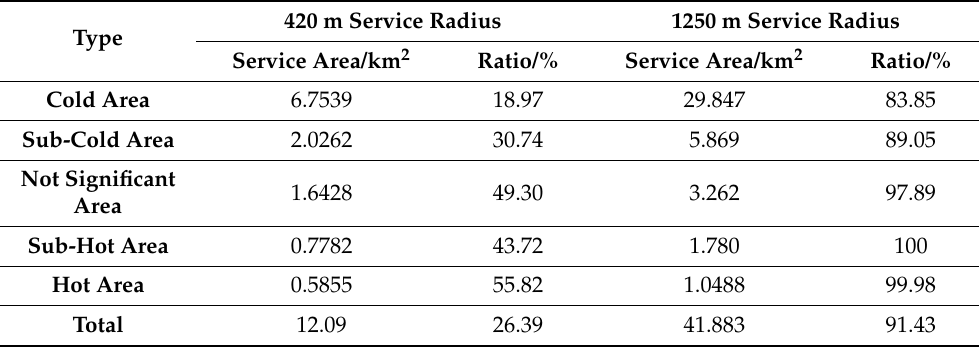
Table 5. Service space statistics of green space alleviating the heat island effect in each living heat